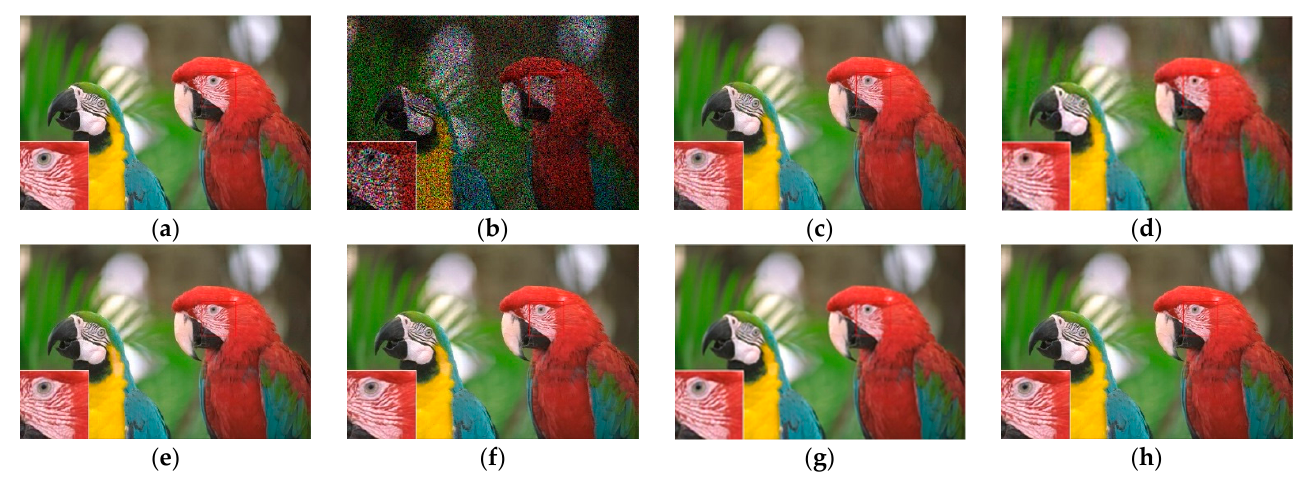
Figure 9. Visual effect comparison of different methods on the color image kodim23. The incomplete image contains 50% missing entries, shown as black pixels. ( a ) Original image; ( b ) Incomplete image; ( c ) FaLRTC (33.35 dB); ( d ) TCTF (29.21 dB); ( e ) LRTC-TNN1 (33.47dB); ( f ) LRTC-TNN2 (33.72 dB);